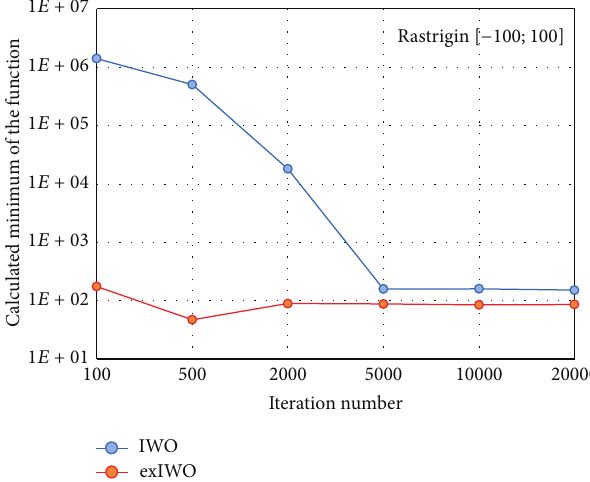
Figure 13: Averaged minima of IWO and exIWO for the 30- dimensional Rastrigin function.